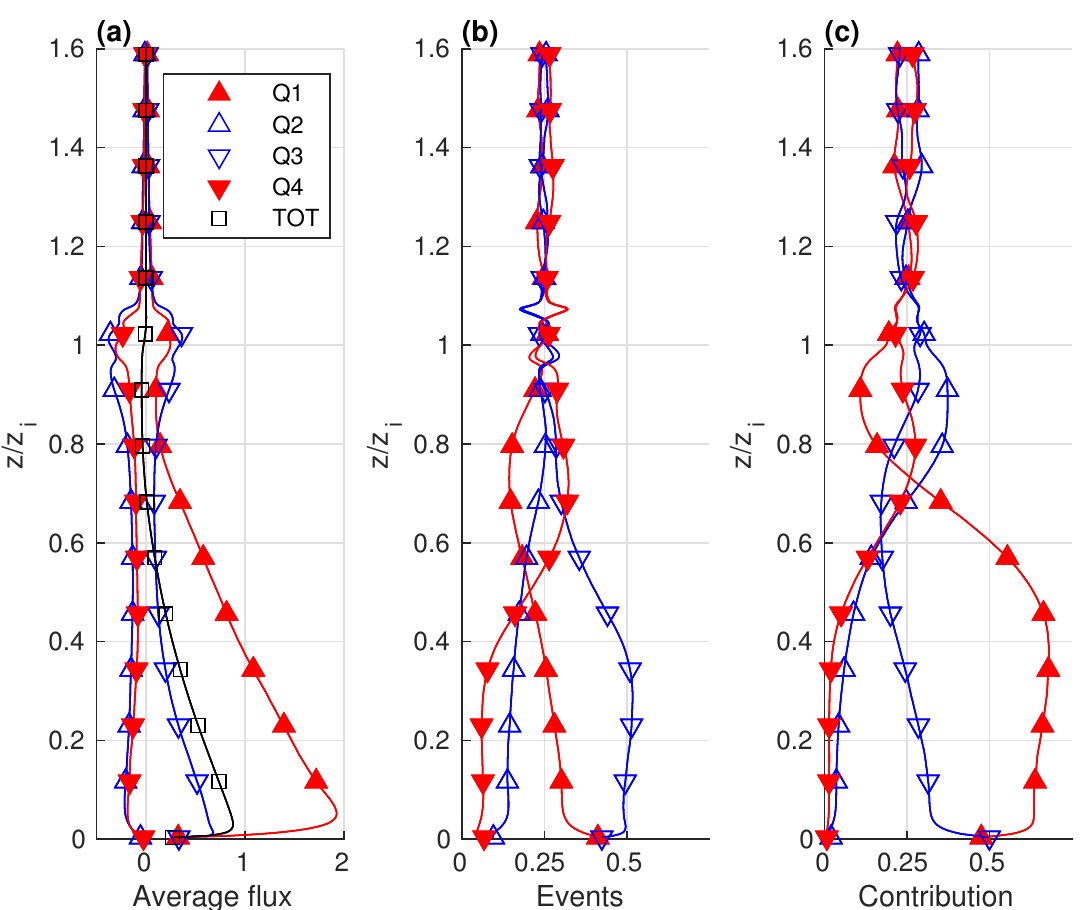
Figure 9. Quadrant analysis of the resolved potential temperature flux for the CBL1 “truth run” with a horizontal grid length of 10 m. ( a ) Average flux per event in each quadrant, normalized by the total potential temperature flux at the surface. Results are shown for Quadrants 1 (red up), 2 (blue up), 3 (blue down) and 4 (red down) and for the total resolved flux (black squares). ( b ) Number of events in each quadrant, normalized by the total for all quadrants. ( c ) Relative fractional contributions of the fluxes in each quadrant, computed as |(cid:104) w (cid:48) θ (cid:48) (cid:105) i | / ∑ i |(cid:104) w (cid:48) θ (cid:48) (cid:105) i |